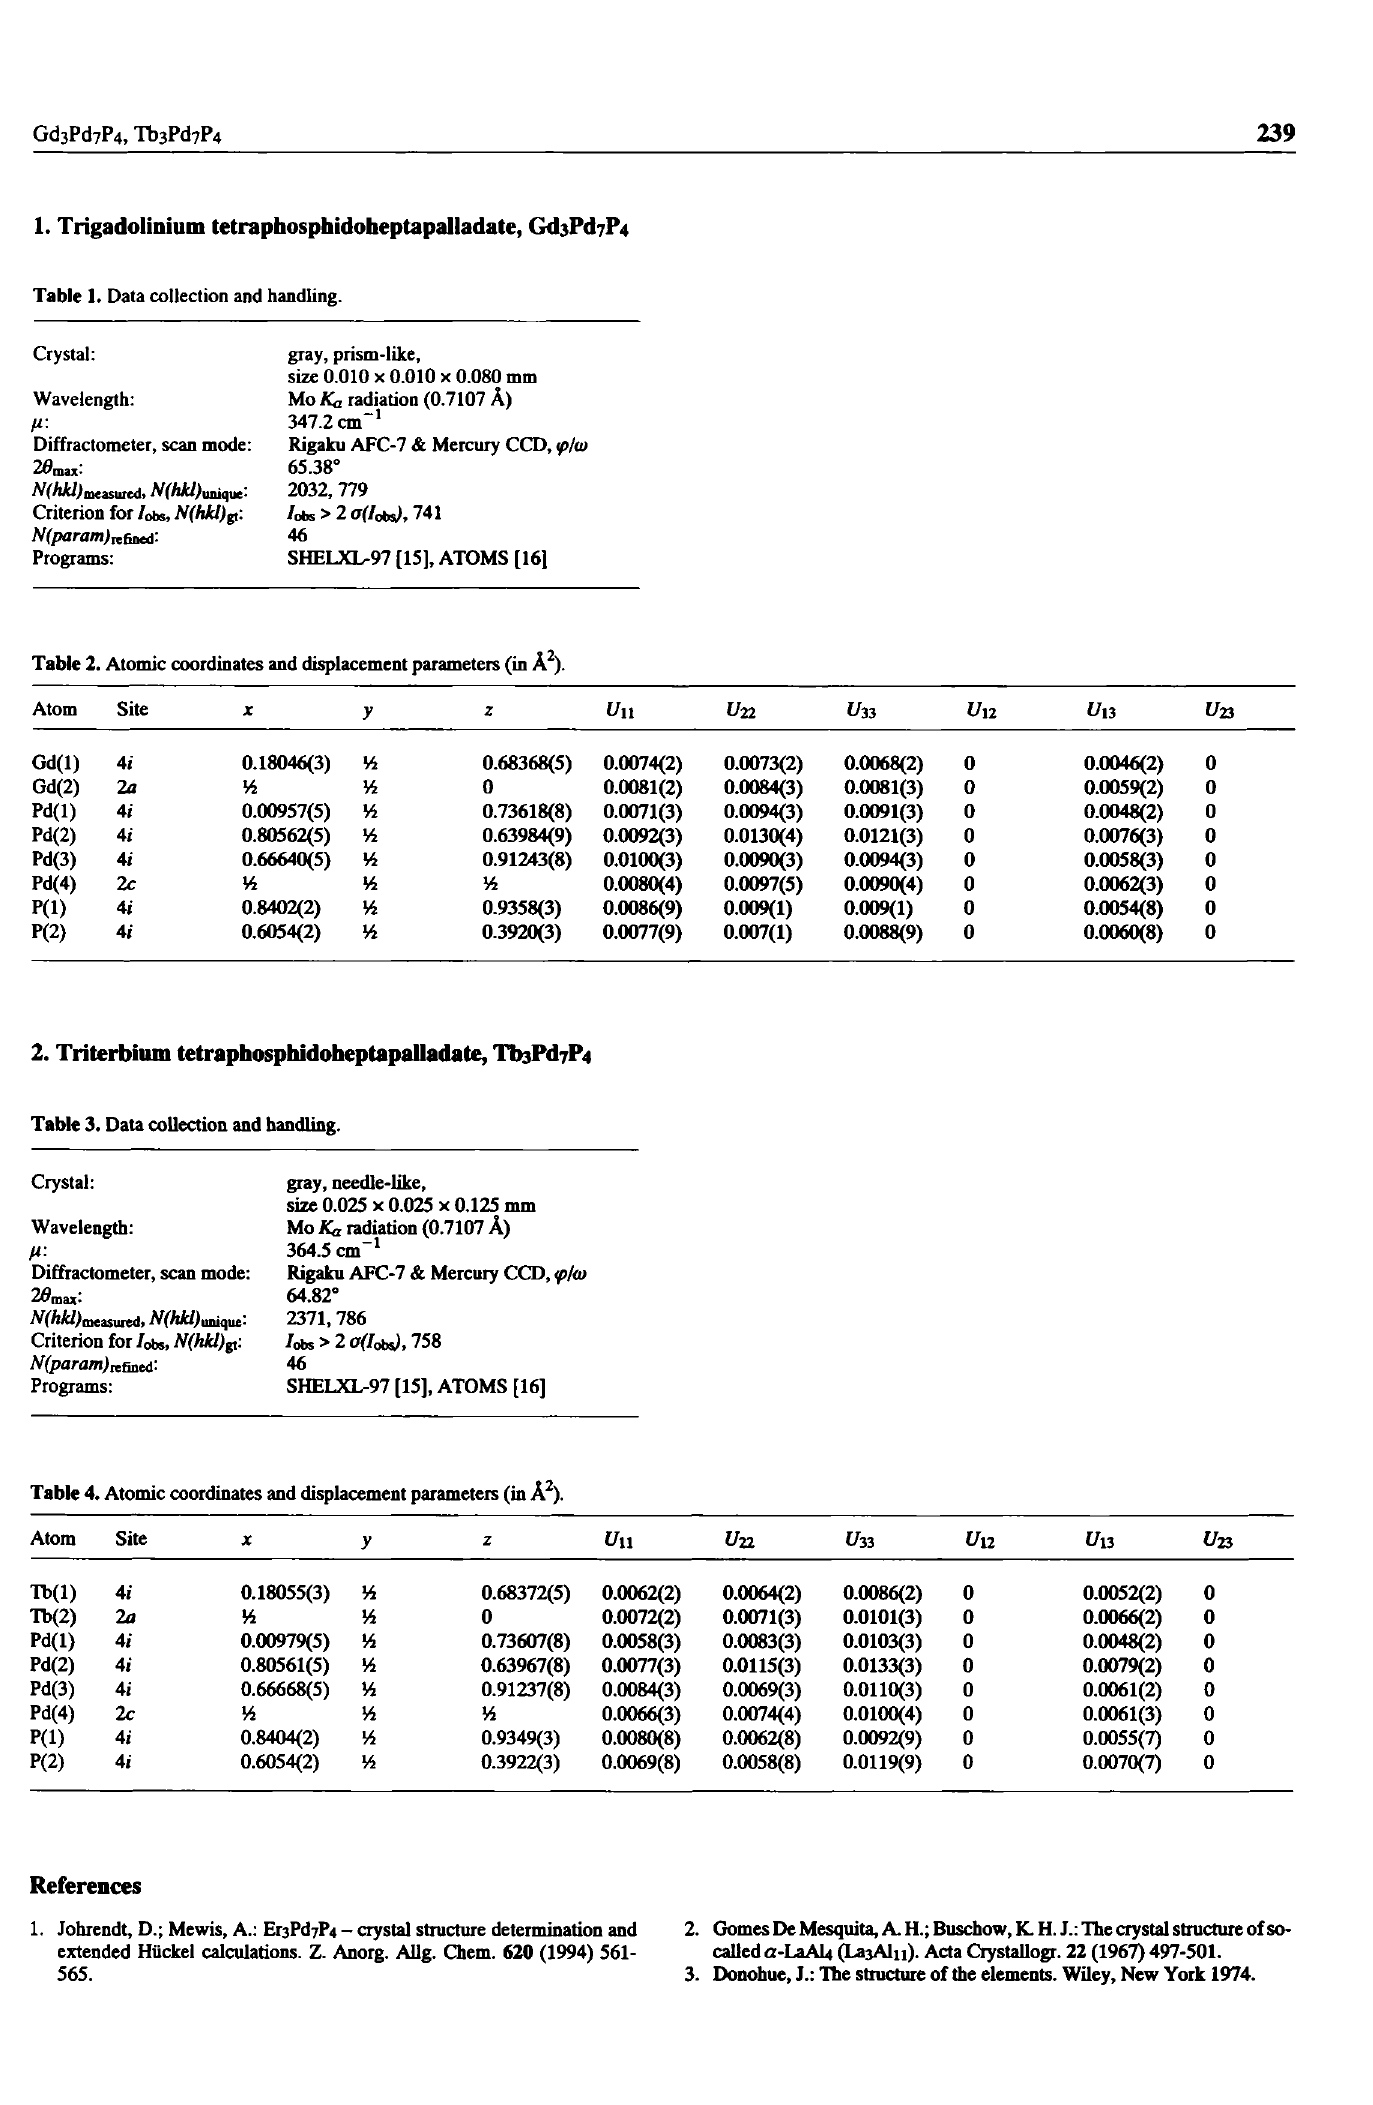
Table 4. Atomic coordinates and displacement parameters (in A 2